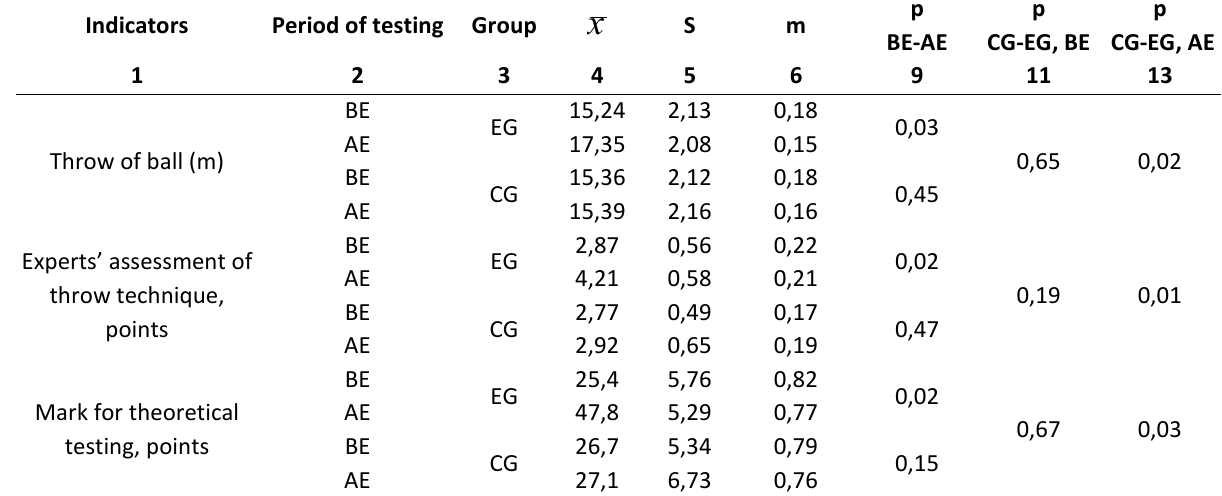
Table 1. Indicators of motor fitness of control (n=22) and experimental (n=21) groups before and after experiment (girls)